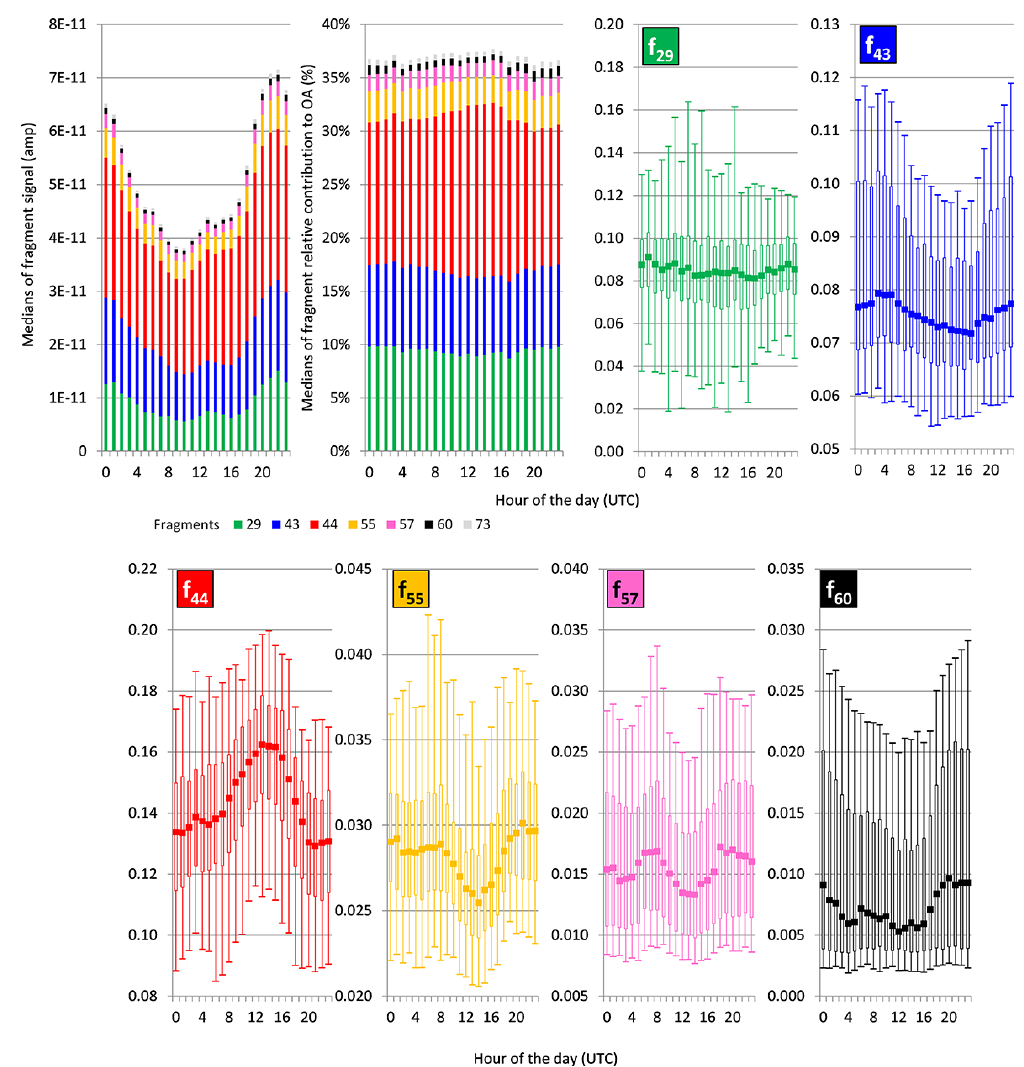
Figure 6. Annual statistics describing the daily cycles of the major organic fragments. Box plots are constructed from the 5th, 25th, 50th, 75th and 95th